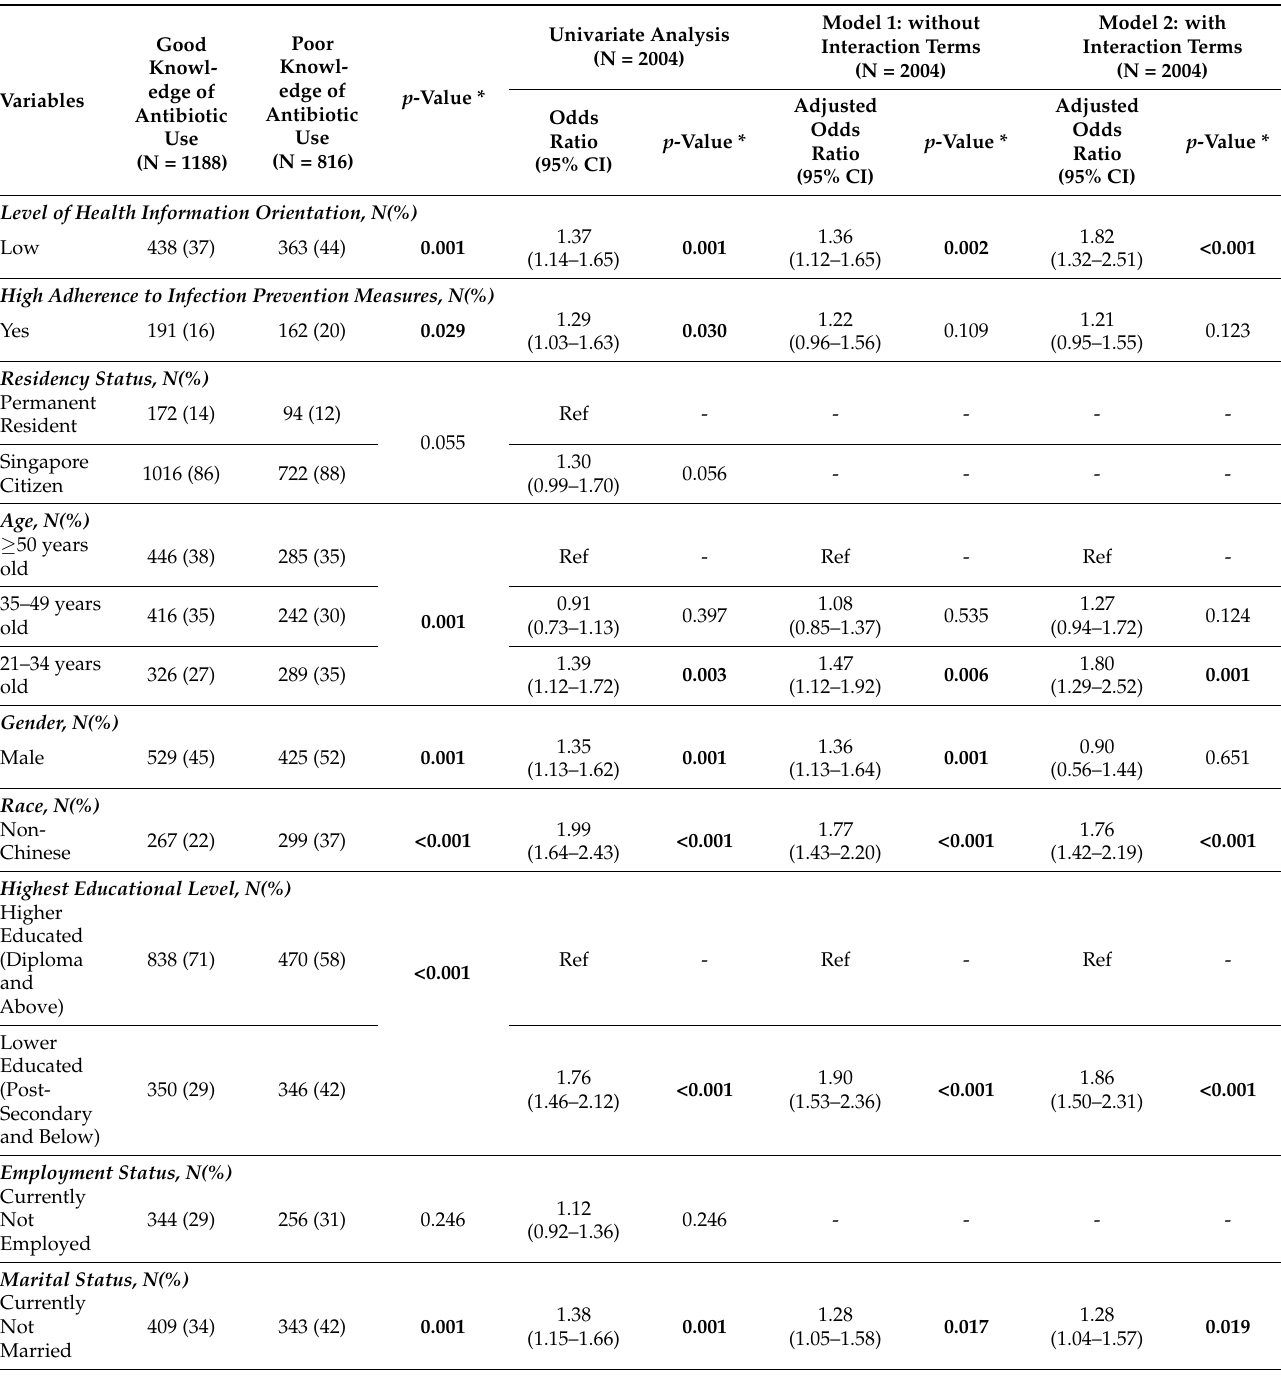
Table 3. Univariate and multivariable logistic regression analyses on factors associated with knowl- edge of antibiotic use (N =